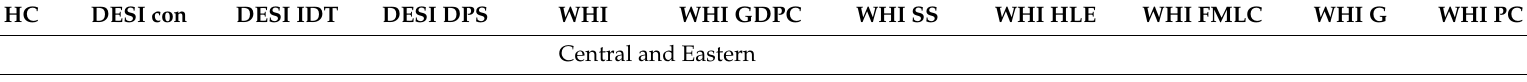
Table 7. Correlations between DESI index and World Happiness Index on EU